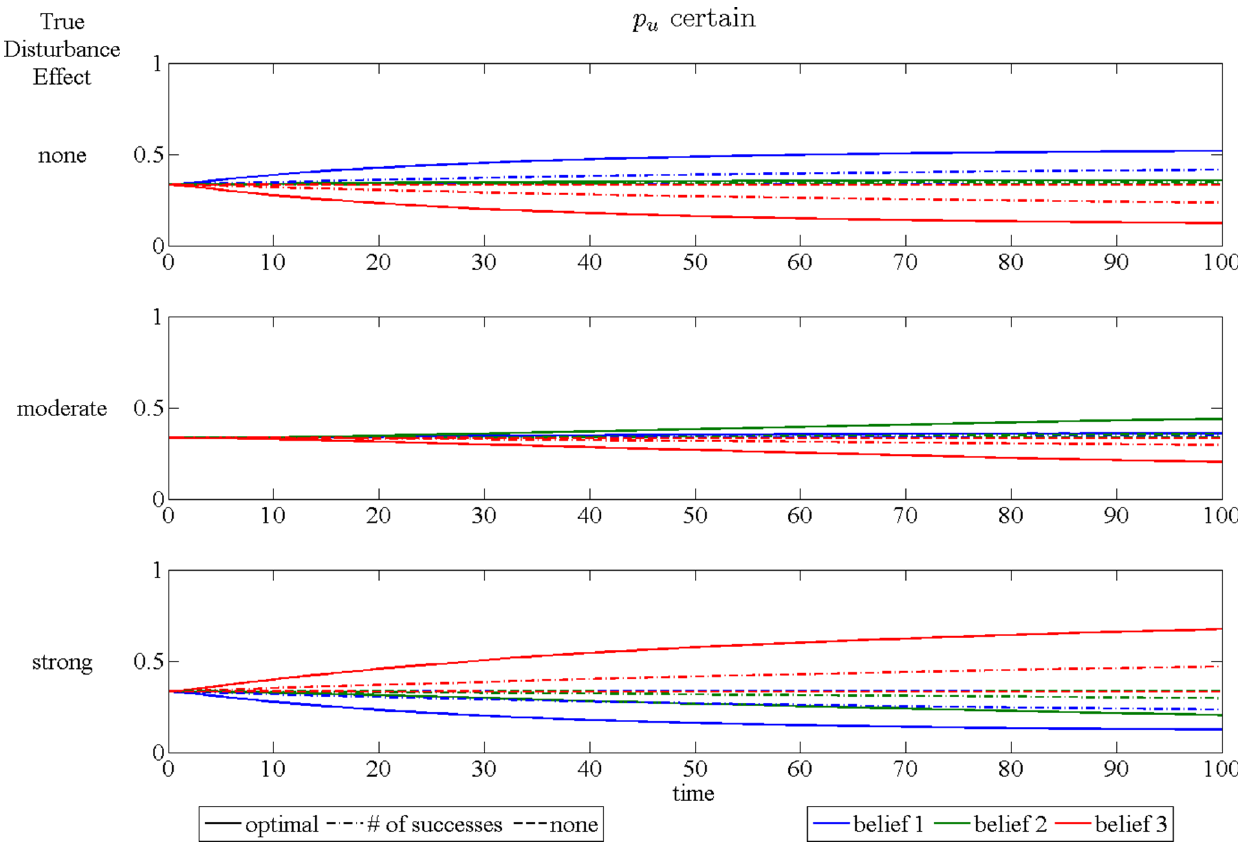
Figure 8. Time paths of expected beliefs when p u is known. The three subplots represent cases for each of the three possible disturbance effect models. Each plot shows time paths of expected beliefs over 100 years. Line color is associated with the belief in a specific disturbance effect: blue – no disturbance, green –moderate disturbance, red – strong disturbance. Line type represents the signal used for updating beliefs: solid – full information, dash/dot – number of successes only, dashed – no signal.